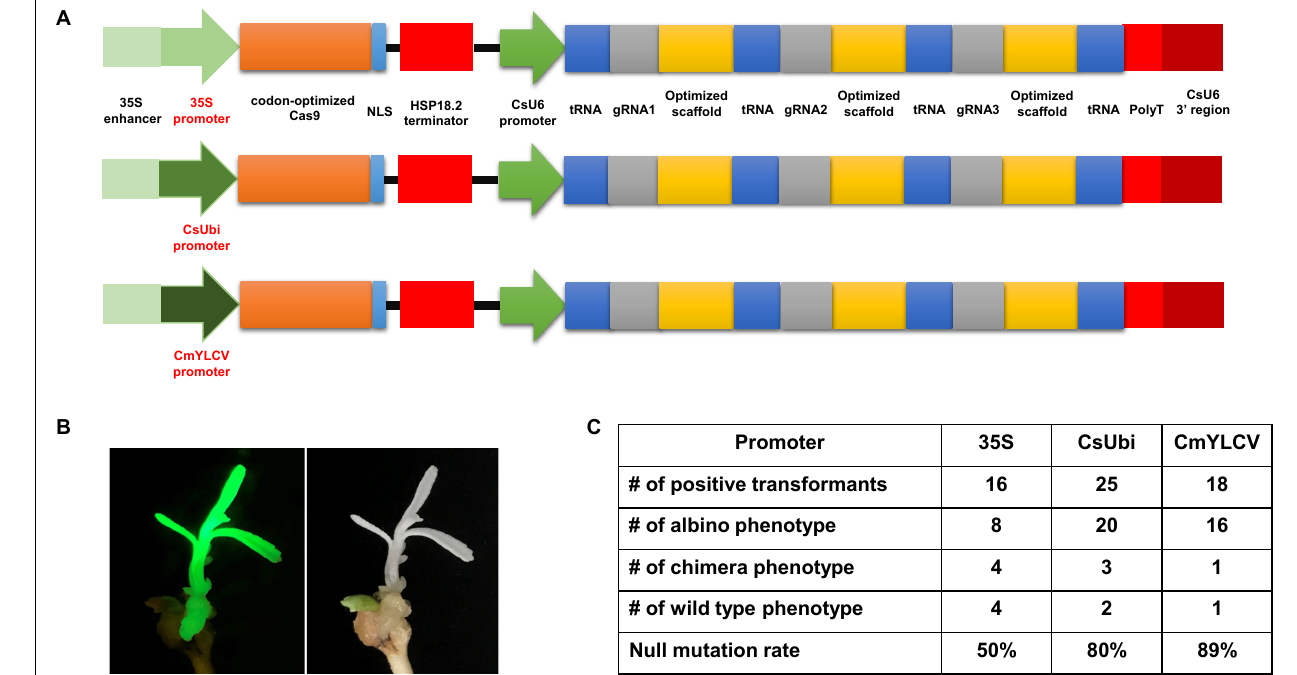
Frontiers in Plant Science |